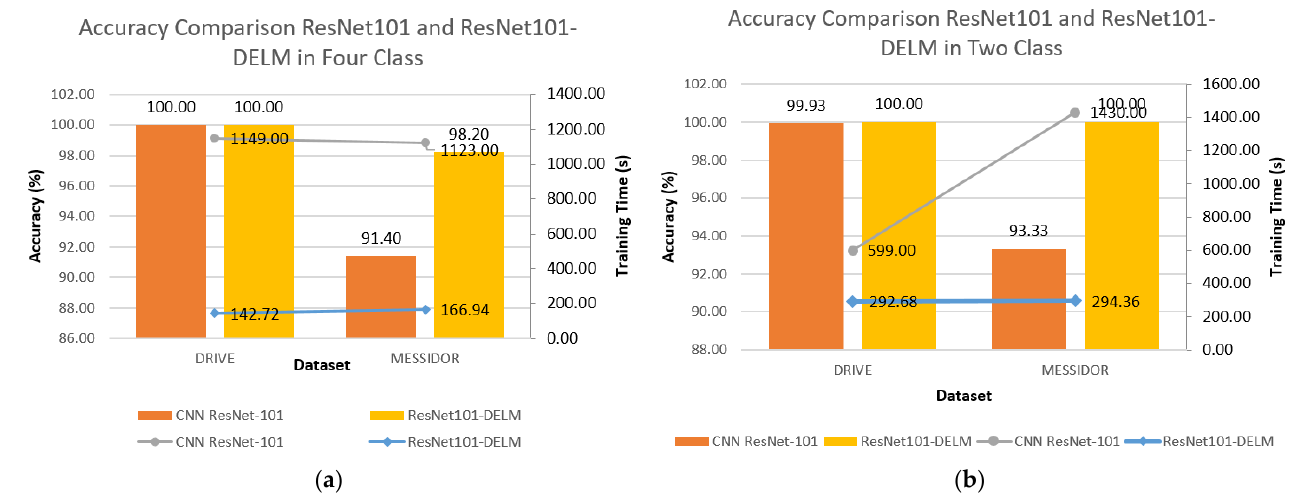
Figure 17. ( a ) Accuracy comparison of ResNet101 and ResNet101-DELM on 4 Class ( b ) Accuracy comparison of ResNet101 and ResNet101-DELM on 2 Class.